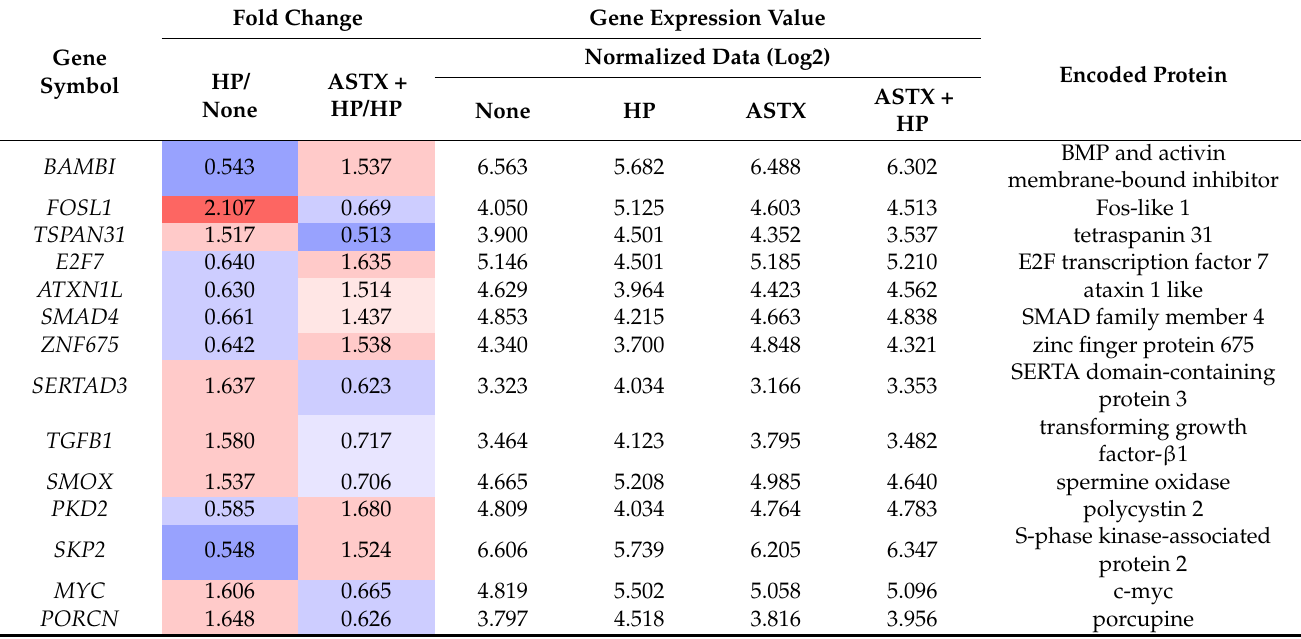
Table 1. Expression levels of differentially expressed genes (DEGs) involved in the Wnt/ β -catenin pathway. The expression level of each gene is reported as the read count normalized to the log2 value. For fold change values, red and blue background color was used to visualize increased and decreased gene expressions respectively, with the intensity of color representing the magnitude of